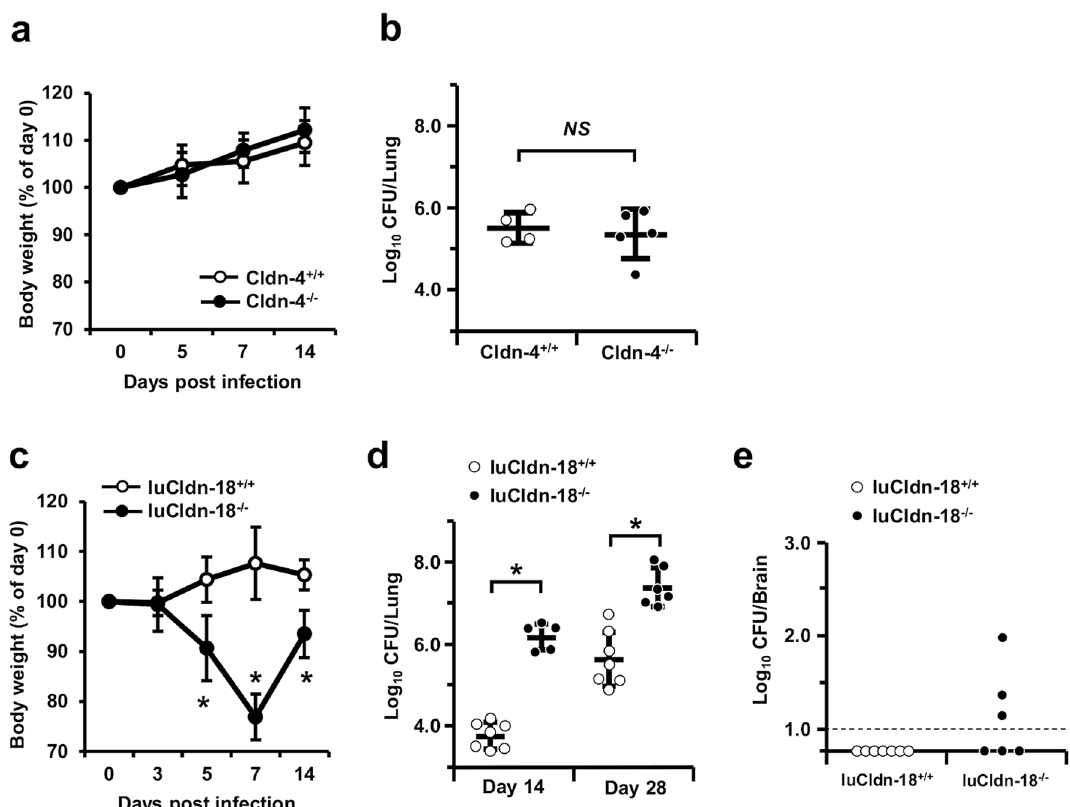
Figure 1. Effect of claudin deficiencies on C. deneoformans infection. ( a , b ) Cldn-4 +/+ (n = 4) and Cldn- 4 −/− mice (n = 5) were infected intratracheally with C. deneoformans. ( a ) Mouse weight is presented as weight relative to the initial weight of each mouse. ( b ) The numbers of live colonies in the lungs were counted on day 14 post-infection. Each symbol represents a separate mouse, and bars indicate the mean ± standard deviation (SD). (c-e) luCldn-18 +/+ (day 14, n = 7; day 28, n = 7) and luCldn-18 −/− mice (day 14, n = 5; day 28, n = 6) were infected intratracheally with C. deneoformans. ( c ) Mouse weight is presented as weight relative to the initial weight of each mouse. The numbers of live colonies in the lungs on days 14 and 28 ( d ) and in the brains on day 28 post-infection ( e ) were counted. Each symbol represents a separate mouse, and bars indicate the mean ± SD. The dashed line indicates the detection limit. *, p < 0.05. NS , not significant. There were no mice excluded from this (Fig. 4d, e). In addition, production of IL-17A in BALF on day 7 and in the lungs on day 14 were significantly lower in luCldn-18 −/− mice than in luCldn-18 +/+ mice (Fig. 4d, e). Effect of luCldn‑18 deficiency on homeostasis of the lung microenvironment. luCldn-18 is involved in alveolar fluid homeostasis by regulating solute and ion permeability between alveolar epithelial cells 27 . The next series of experiments examined the effect of luCldn-18 deficiency on the homeostasis of the lung microenvironment. In a steady state, K + ion concentration in BALFs was significantly higher in luCldn-18 −/− mice than in luCldn-18 +/+ mice, while pH was significantly lower (Fig. 5a). Airway surface liquid pH can be altered by disease and lung inflammation, in part because airway inflammation promotes acidification 37 . Alveo- lus acidification was observed after cryptococcal infection in both genotypes (Fig. 5b). In addition, alveolar pH remained significantly lower in luCldn-18 −/− mice than in luCldn-18 +/+ mice until at least seven days after infection (Fig. 5b).